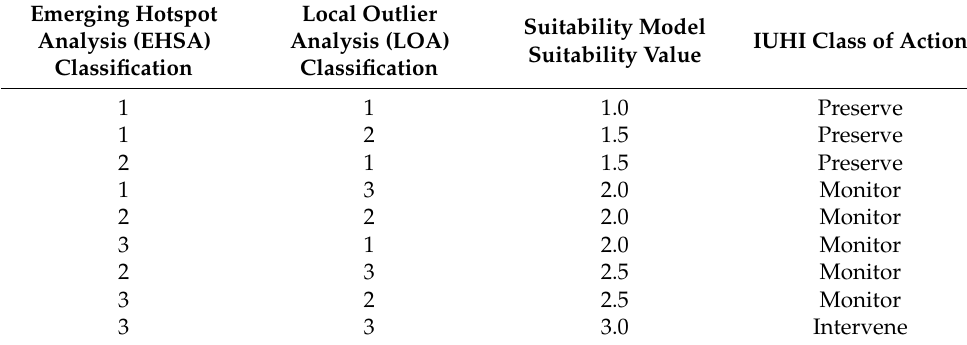
Table 11. Suitability values and their equivalent IUHI Class of